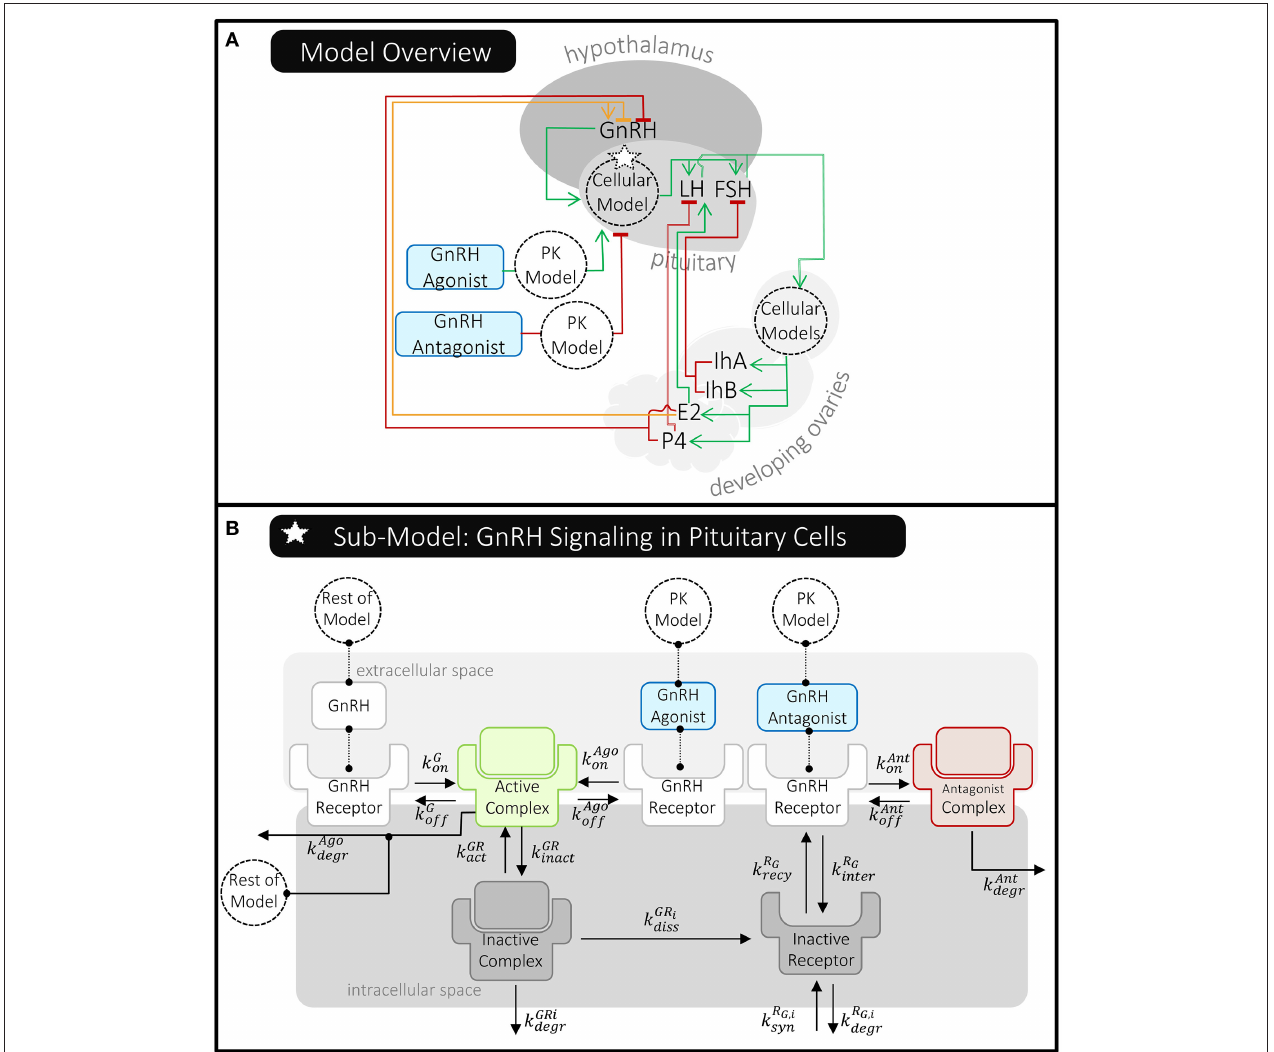
FIGURE 7 | Overview of Röblitz et al.’s (27) quantitative systems pharmacology model of the menstrual cycle and gonadotropin-releasing hormone (GnRH) therapies. (A) This schematic shows where molecules are produced and whether they stimulate (green line/arrow head), inhibit (red line/flat head), or have a mixed effect (orange line/both) on the production of other molecules in this model. The dotted circles labeled “Cellular Model(s)” represent processes affecting pituitary GnRH receptors and ovarian LH/FSH receptors that have been modeled in detail. The delivery of GnRH agonist and antagonist are modeled using PK models that feed into the pituitary cellular model. (B) The pituitary cellular model is summarized here. Each reaction has a unique reaction rate constant ( k ) that can depend on the receptor state (e.g., whether it’s internalized or the specific molecule it’s bound to). For simplicity, reactions involving an active complex have just been shown once; however, the rates of these processes do depend on the receptors’ states, as described in Röblitz et al.